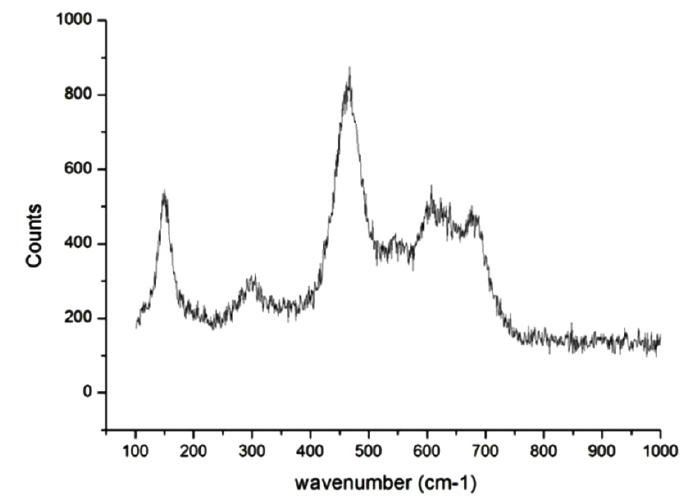
Figure 9. Raman spectrum of CoFe 2 O 4 @SiO 2 @TiO 2 core-shell